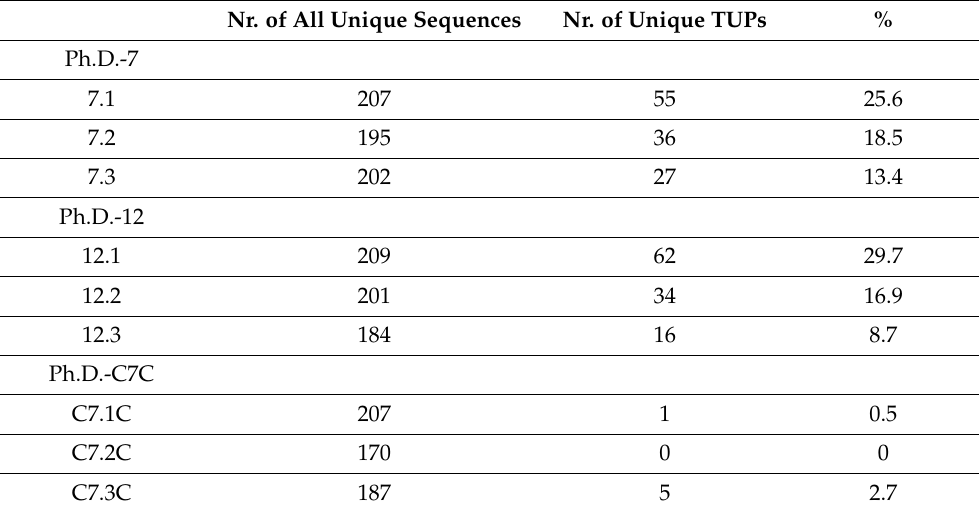
Table 1. Removal of target unrelated peptides (TUPs) through the selection process. With each panning round, the percentage of TUPs decreases in linear libraries, whereas the cyclic library results in the lowest percentage of TUPs after the second panning round where, in fact, no TUPs were detected. Nr. of All Unique Sequences